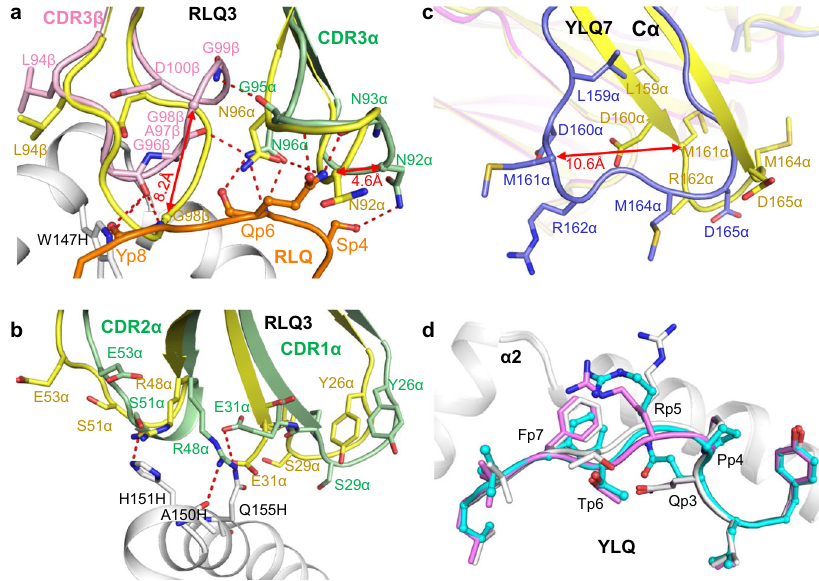
Fig. 7 Conformational changes in TCRs and pMHC after complex formation. a Structural rearrangements in CDR3 β and CDR3 α of RLQ3 (unbound pRLQ3, yellow; bound RLQ3, light green or pink) induced by binding to RLQ – HLA-A2 (RLQ, orange; HLA-A2, gray). Hydrogen bonds are red dotted lines. Double-headed red arrow indicates region of structural shifts. b Structural rearrangements in CDR1 α and CDR2 α of RLQ3. c Superposition of the C α domain of TCR YLQ7 in unbound form and in complex with YLQ – HLA-A2 (unbound YLQ7, yellow; bound YLQ7, blue). Double-headed red arrow indicates site of structural differences in C α associated with YLQ – HLA-A2 binding. d Superposition of YLQ – HLA-A2 in unbound form and in complex with TCR YLQ7 showing rearrangements in residues P4 – P7 of the YLQ peptide induced by YLQ7 binding (unbound YLQ, gray or violet; bound YLQ, cyan; HLA-A2,